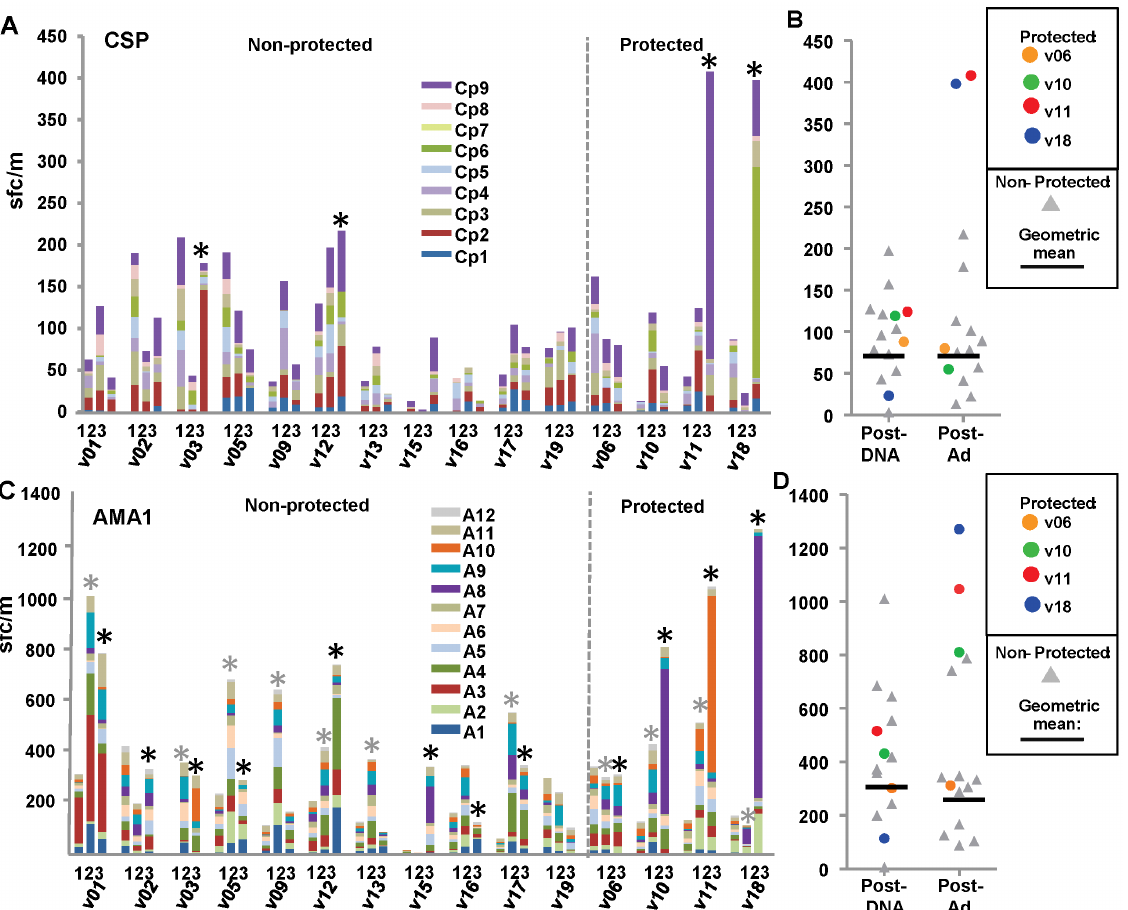
Figure 2. DNA/Ad ELISpot IFN- c activities to CSP and AMA1 peptide pools. Panels A and C: ELISpot activities (sfc/m) of each volunteer to CSP or AMA1 peptide pools are shown as color coded stacked bars at pre-immunization (1), 28 days after DNA immunization (2) and 22/23 days after the Ad boost (3). *Positive activities. Panels B and D: ELISpot activities were summed and protected subjects shown as color-coded dots. Horizontal bars represent geometric mean activities of non-protected volunteers. The geometric means of summed activities of non-protected volunteers and the activities of each protected volunteer are shown in Table 1. Panel A: CSP: All volunteers were negative after DNA immunization, but four volunteers were positive after Ad boost including protected v11 (408 sfc/m) and v18 (398 sfc/m) that were above non-protected volunteers, whereas protected v06 and v10 were negative. Most activity of v11 and v18 was directed to single CSP peptide pools. Panel B: CSP: Geometric means of non- protected volunteers remained similar after DNA immunization and Ad boost when v11 and v18 were higher than all other volunteers. Panel C: AMA1: 11 volunteers were positive after DNA immunization (*gray), and 11 were positive after Ad boost (*black), including protected v10 (810 sfc/m), v11 (1046 sfc/m) and v18 (1270 sfc/m) that were above non-protected volunteers, whereas protected v06 was within the range of non-protected volunteers. Most activity of v10, v11 and v18 was directed to single AMA1 peptide pools. Panel D: AMA1: Geometric means of non-protected volunteers were higher Ad boost when v10, v11 and v18 higher than all